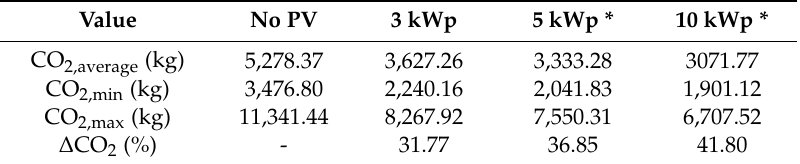
Table 3. CO 2 emission and average ∆ CO 2 emissions for di ff erent PV capacities (n = 55).